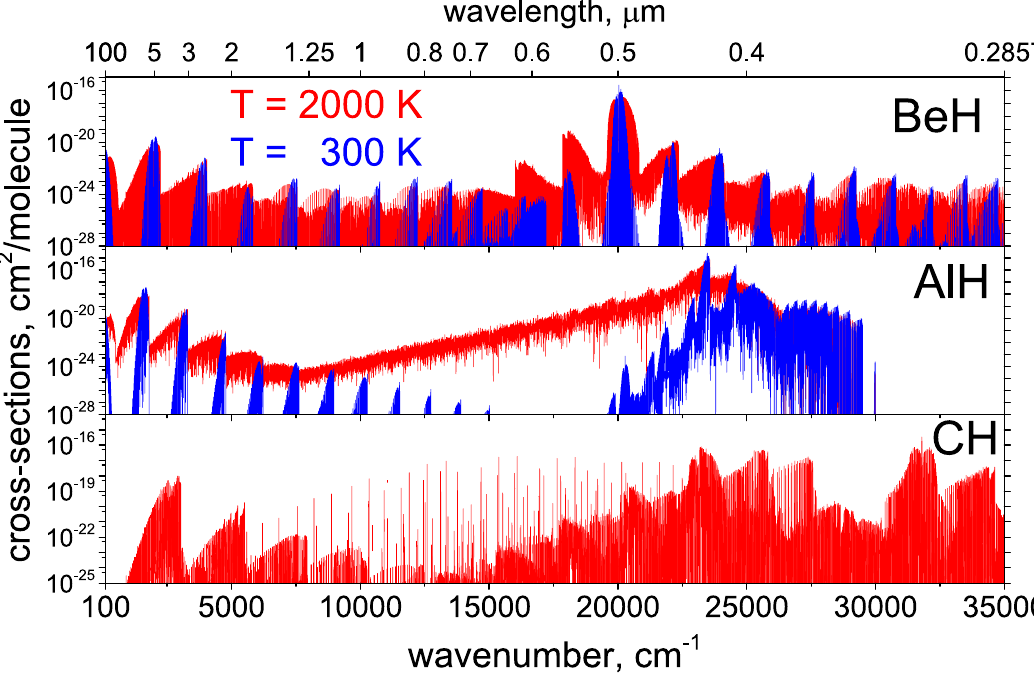
Figure 7. Cross sections for alkaline earth monohydrides and CH. BeH uses the updated ExoMol line list of Darby-Lewis et al. [138], AlH is the new ExoMol line list [76] and CH is the empirical work of Masseron et al. [83]; the CH line list is only defined for T > 1000